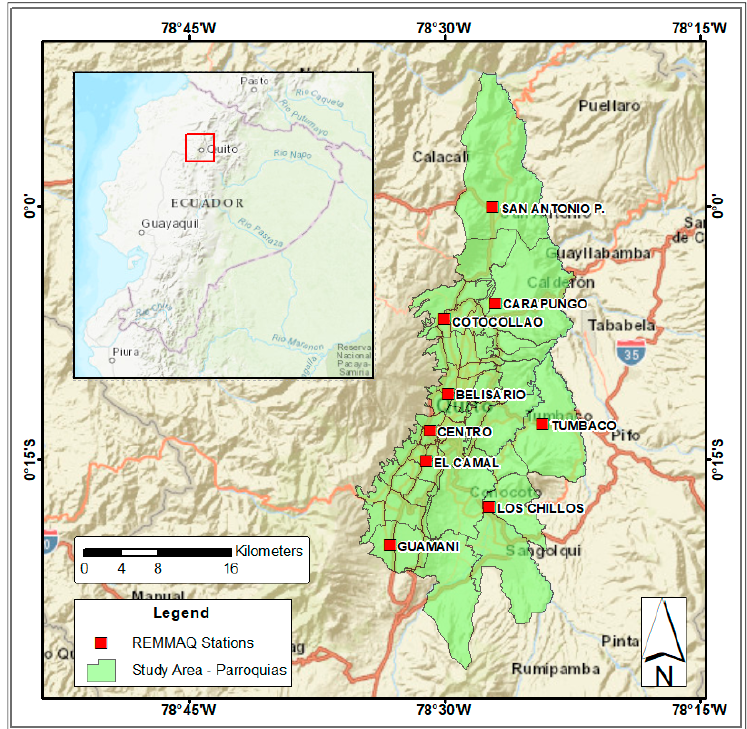
Figure 1. Map of the study area (red dots for REEMAQ (Red Metropolitana de Monitoreo Atmosférico de Quito) stations and green polygons for urban parishes).